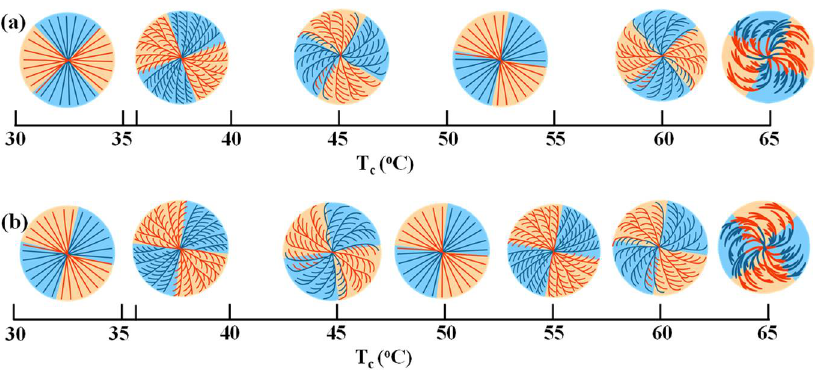
Figure 5. Schematics for the birefringent patterns of ( a ) (R)-MA/PVPh (50/50) and ( b ) (S)-MA/PVPh (50/50) blend at different crystallization temperatures.